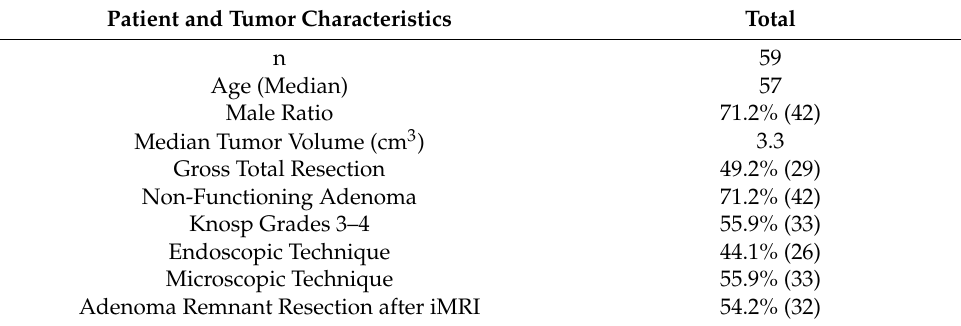
Table 1. Patients’ and tumor